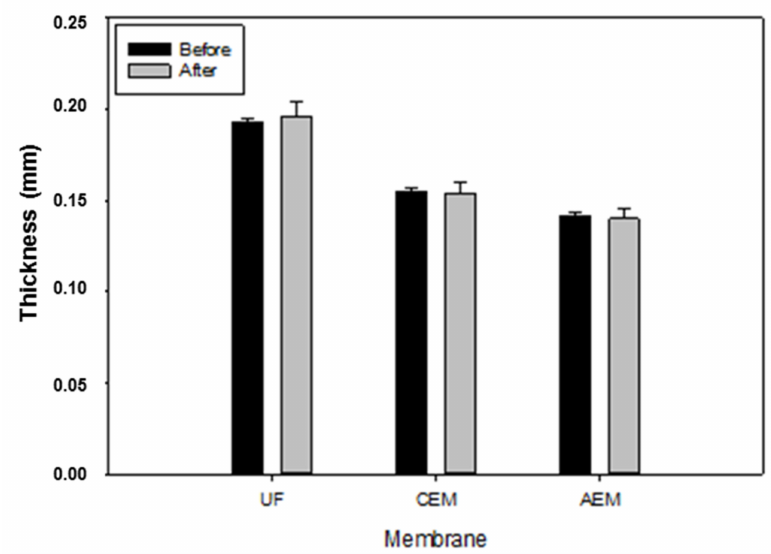
Figure 8. Average thickness of ultrafiltration (UF), cationic (CEM), and anionic (AEM) membranes before and after the EDUF process. t-test was performed at p ≤